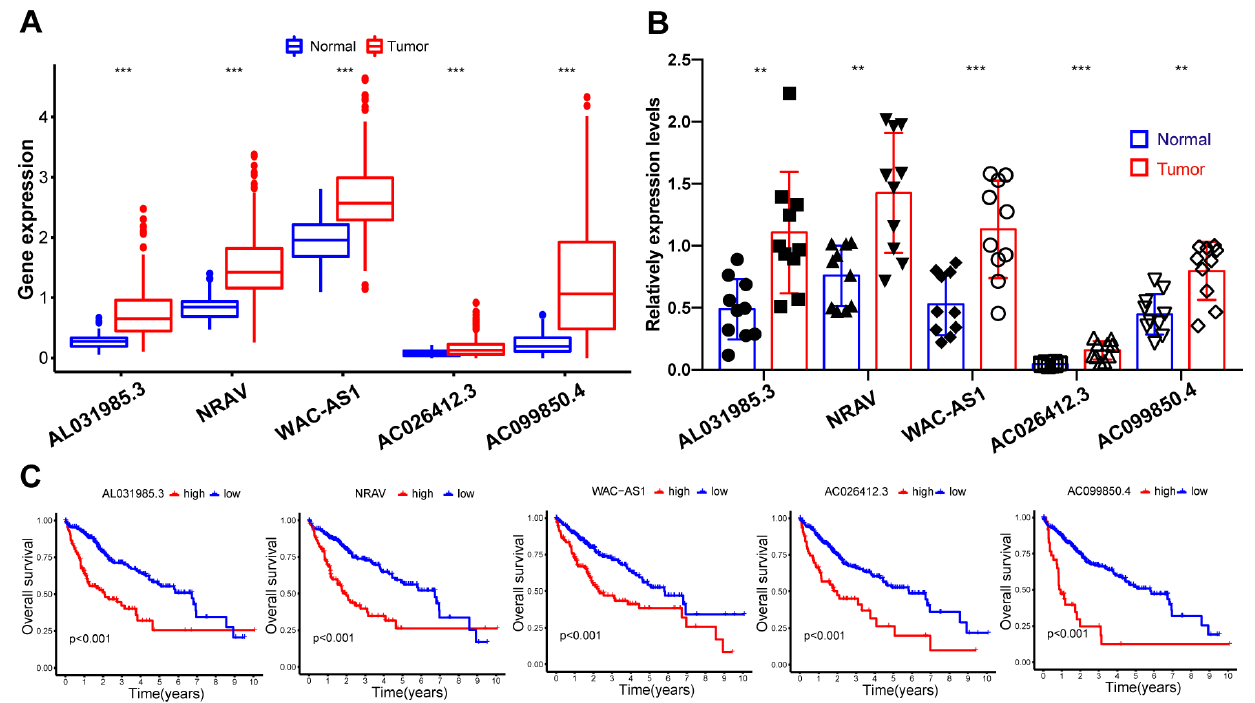
Figure 7. Expression patterns and prognostic values of five identified lncRNAs. ( A ) Differential expression of five lncRNAs between normal and tumor tissues in TCGA dataset. ( B ) Validation of the expression patterns of five lncRNAs based on ten cases of HCC tumor tissues and their adjacent para-tumor tissues from ten surgically resected HCC patients by qRT-PCR analysis. ( C ) The association of each lncRNA’s expression level with HCC patients’ prognosis in the TCGA database. Long non-coding RNAs, lncRNAs; Hepatocellular carcinoma, HCC; The Cancer Genome Atlas, TCGA; Quantitative real-time polymerase chain reaction, qRT-PCR. Each symbol in the figure B represents the expression level of the lncRNA in each individual. **, p < 0.01; ***. p < 0.001.